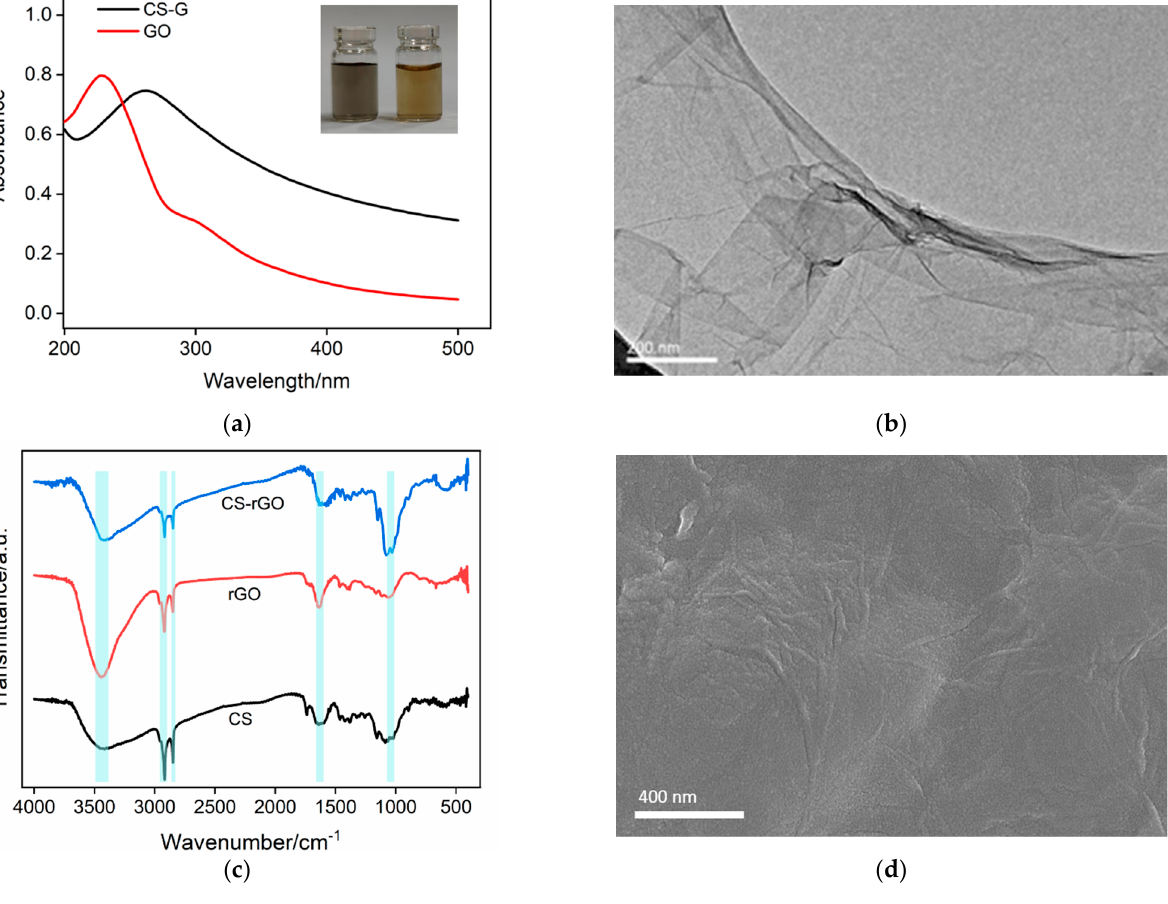
Figure 3. ( a ) UV-Vis absorption spectrum of GO and CS-rGO. Insets are photographs of rGO (left) and GO (right) solutions. ( b ) TEM image of CS-rGO. ( c ) FT-IR spectra of CS, rGO synthesized in absence of CS and CS-rGO. ( d ) SEM image of CS-rGO/ITO.